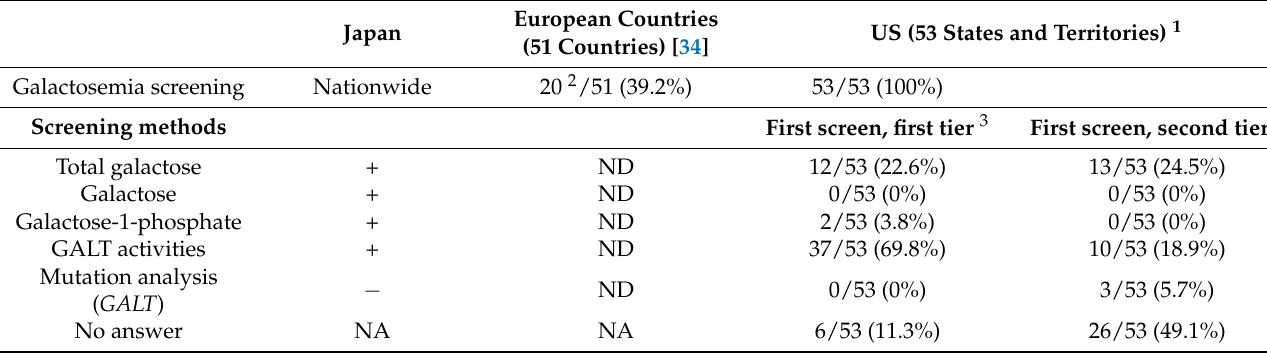
US (53 States and Territories)